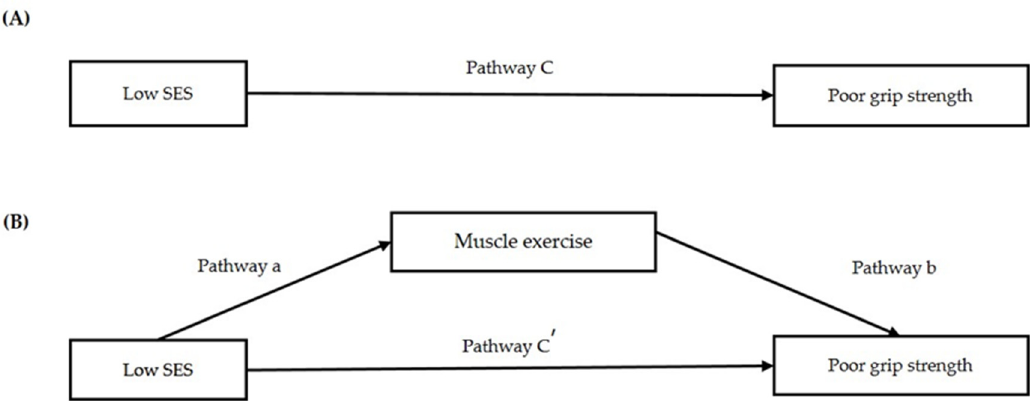
Figure 3. Regression coefficients for the association ( A , B ) between low SES and poor grip strength, as mediated by muscle exercise. Table 3. Mediating effect of muscle exercise on the association between (A) low household income, (B) low education state, and poor HGS.